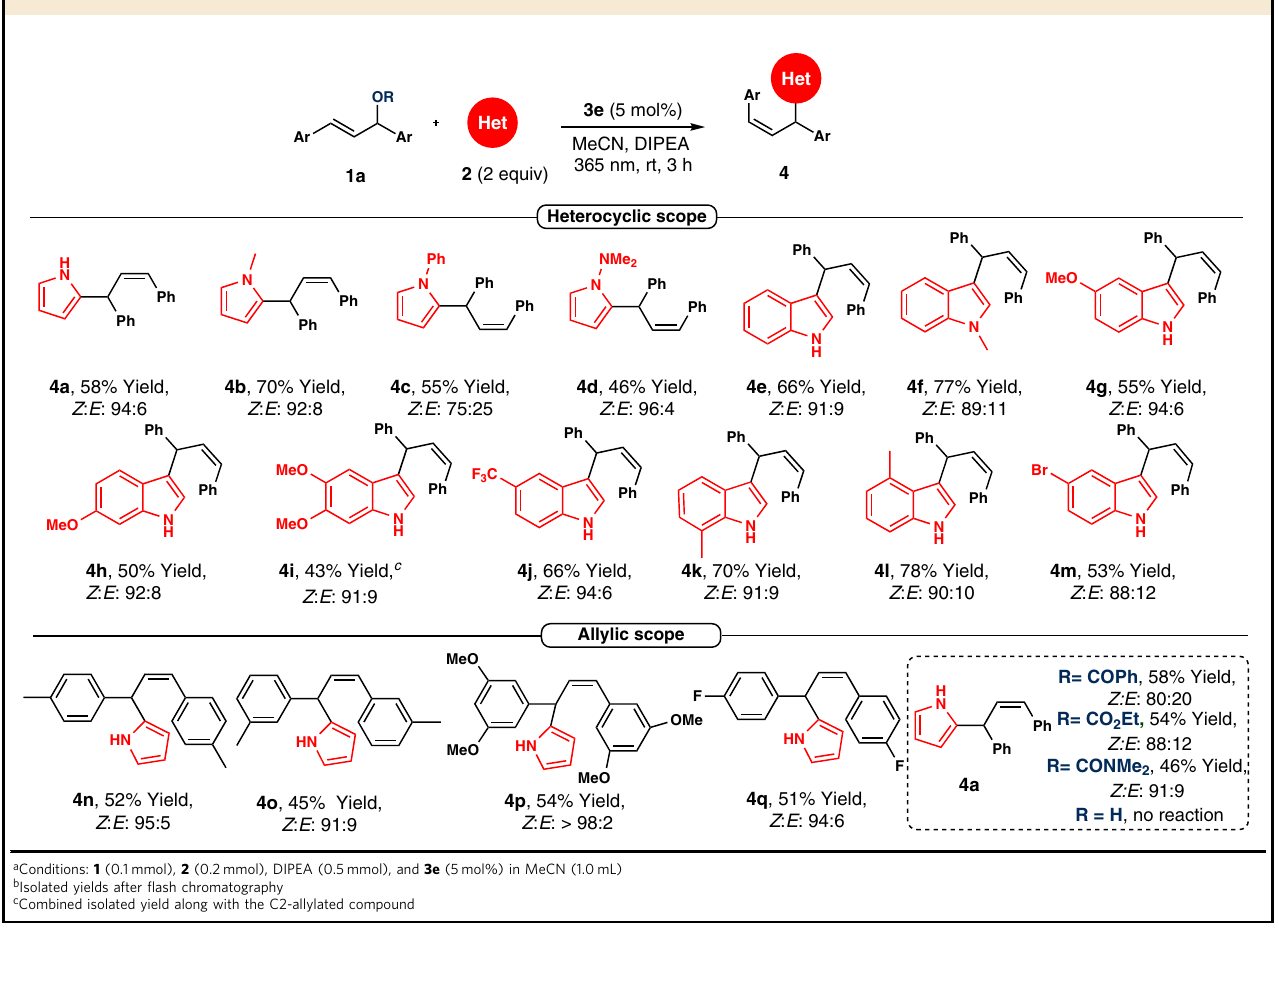
Table 2 Scope of the allylation reaction for the synthesis of Z -isomers with pyrroles and indoles under catalyst 3e a,b